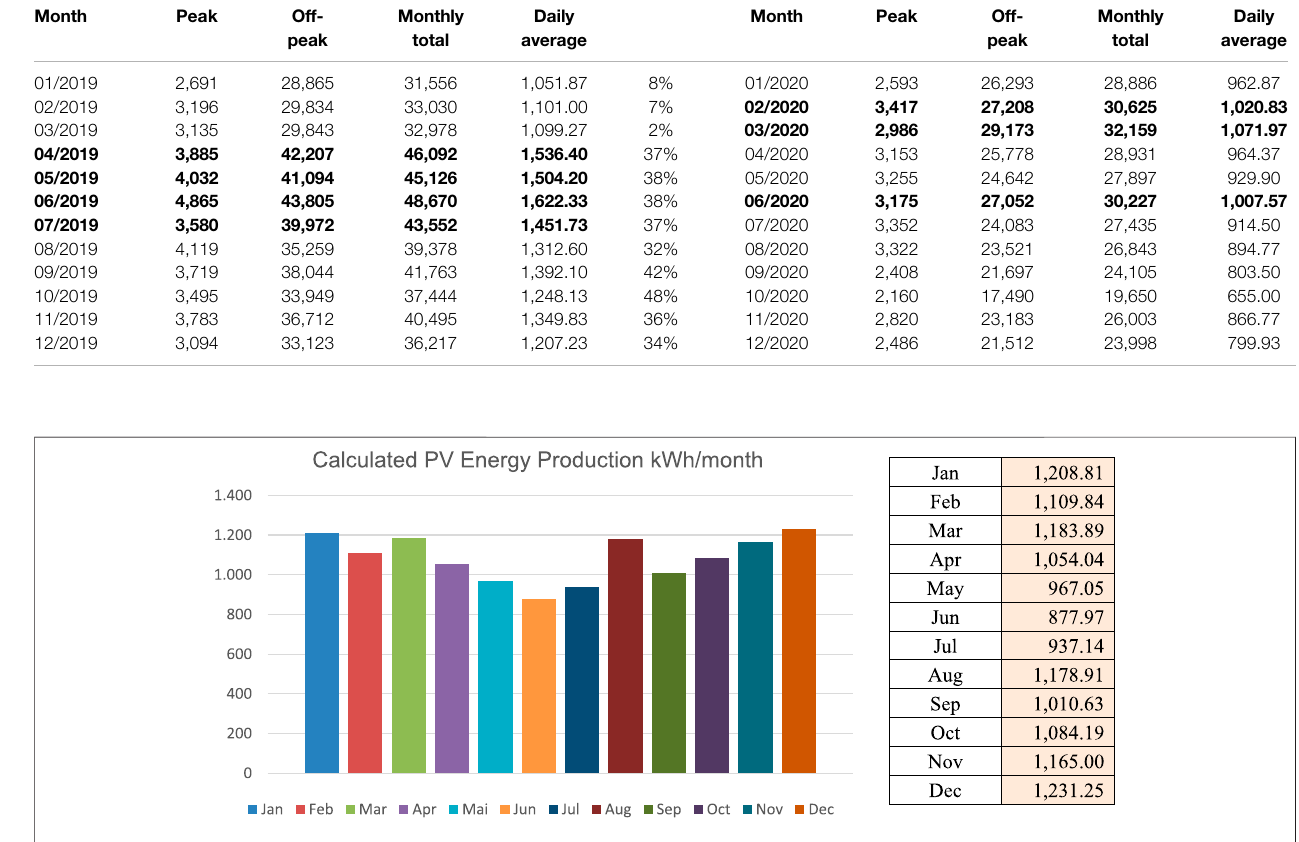
FIGURE 5 | Calculated PV generation for the PV-Bat system of 10.72 kWp. Data sources: the authors.